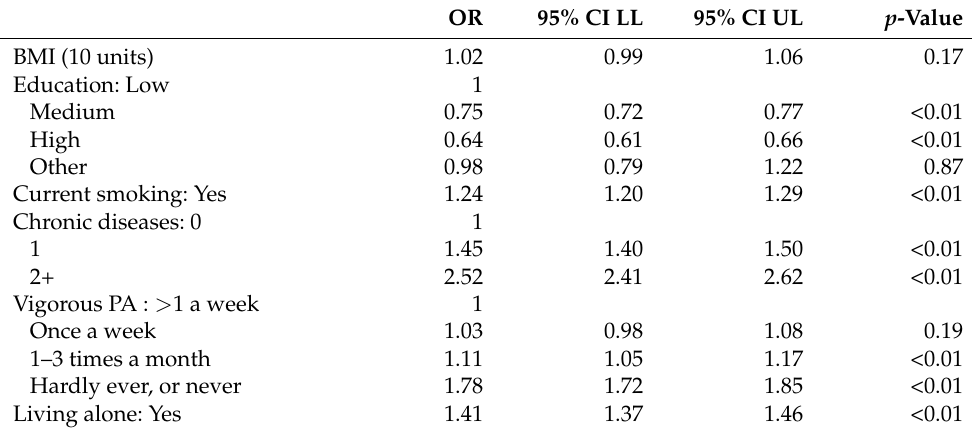
Table 3. Estimated OR (with 95% CI and p-value) obtained from logistic regression models including two-way interactions between age, sex and region and additional risk factors (education, BMI, current smoking, presence of chronic disease, vigorous physical activity, living arrangement; adjusted model); age was modelled using restricted cubic splines (rcs). Estimates for age, sex and region and their two-way interactions are omitted but presented graphically in Figure 2; see Table 1 for sample sizes within each region and by sex, and for descriptive